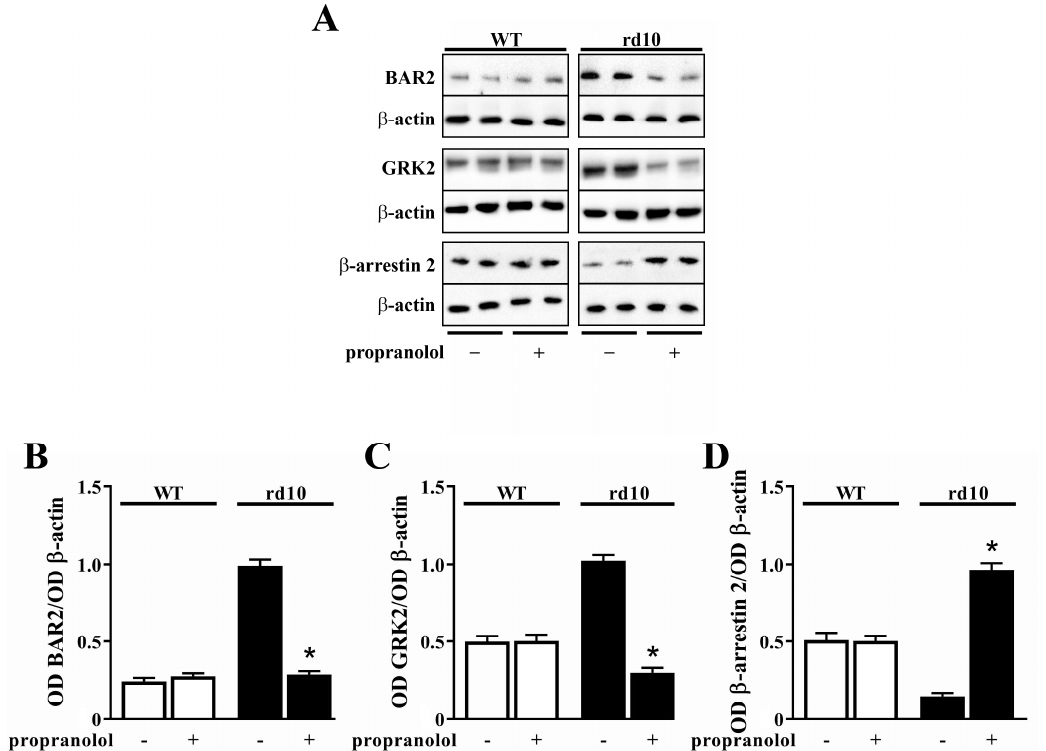
Figure 4. Expression of BAR2, GRK2 and β -arrestin 2 in the retina of WT and rd10 mice untreated or treated with propranolol. ( A ) Representative Western blots from retinal homogenates. ( B – D ) Densitometric analysis of BAR2 ( B ), GRK2 ( C ) and β -arrestin 2 ( D ) levels. In WT mice, propranolol did not affect the expression of BAR2, GRK2 or β -arrestin 2. In rd10 mice, propranolol reduced BAR2 and GRK2 levels, while increased β -arrestin 2 levels ( n = 5 samples per group, each containing 2 retinas from independent mice). * p < 0.001 versus untreated rd10 (one-way ANOVA followed by the Tukey post-hoc test).